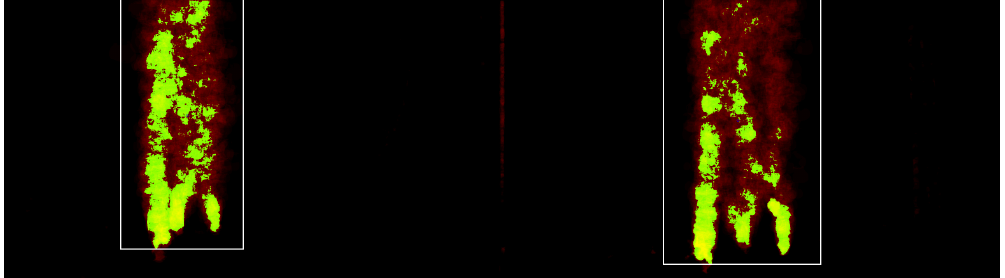
Figure 7. Heat map showing the automatically determined bounding boxes ( white ) for bubble detection in the left and right stereo